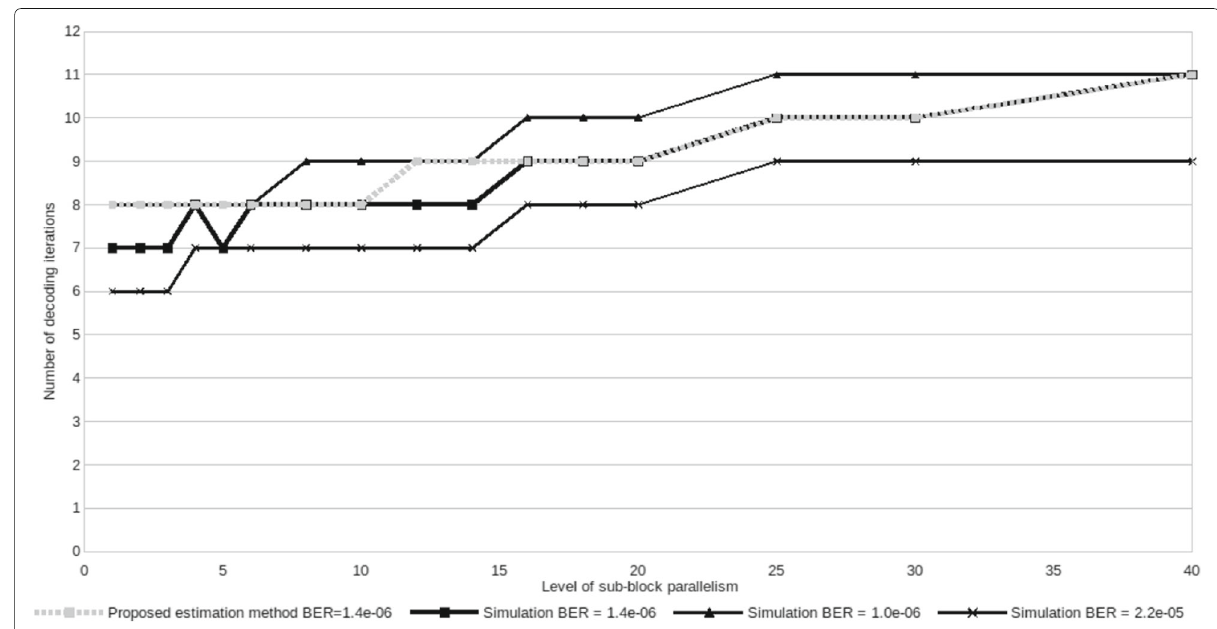
Fig. 6 Number of iterations with message passing method, WiMAX, Max-Log MAP, code rate = 2/3, 1920 bits frame, SNR = 2.3 dB